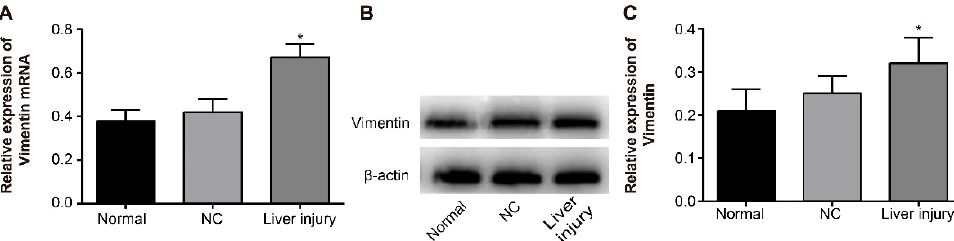
Figure 3. Liver tissues of rats with liver injury exhibited increased Vimentin expression. Panel A , mRNA expression of Vimentin in liver tissue of rats with liver injury measured by RT-qPCR; panel B , C , the protein expression of Vimentin in liver tissue of rats with liver injury measured by Western blot; * p < 0.05, vs. the normal by water and NC groups by PEG solution. The results are given as means ± SD ( n = 10 rats). Enumeration data were performed according to ANOVA with chi-square test ( p < 0.05).